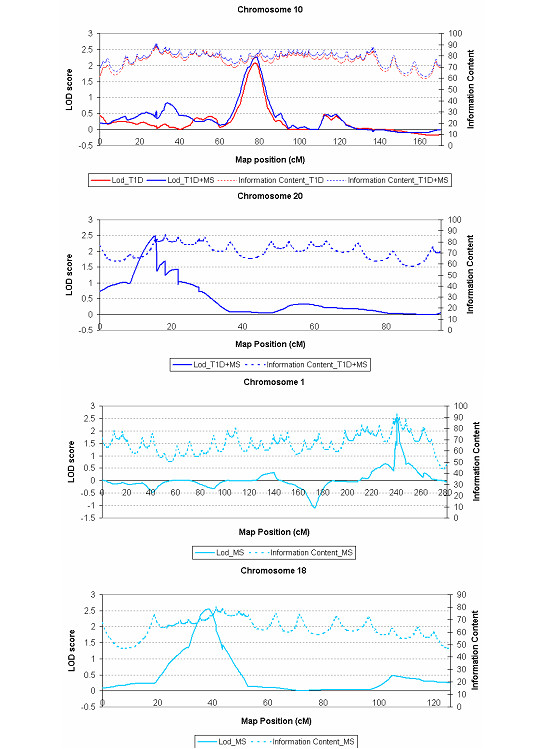
Non-parametric linkage analysis of chromosome intervals showing preliminary evidence of linkage after increasing marker density. The graphs refers to chromosome 10 in the T1D and T1D_MS scan, chromosome 20 in T1D_MS scan and chromosomes 1 and 18 in the MS scan. Reading from the left Y-axis, LOD score results are shown for each chromosome, proceeding from the short-arm telomere to the long arm telomere. The right Y-axis reports the corresponding information content for each point. The T1D, MS and combined T1D_MS sample sets are described in the Materials and Methods section.